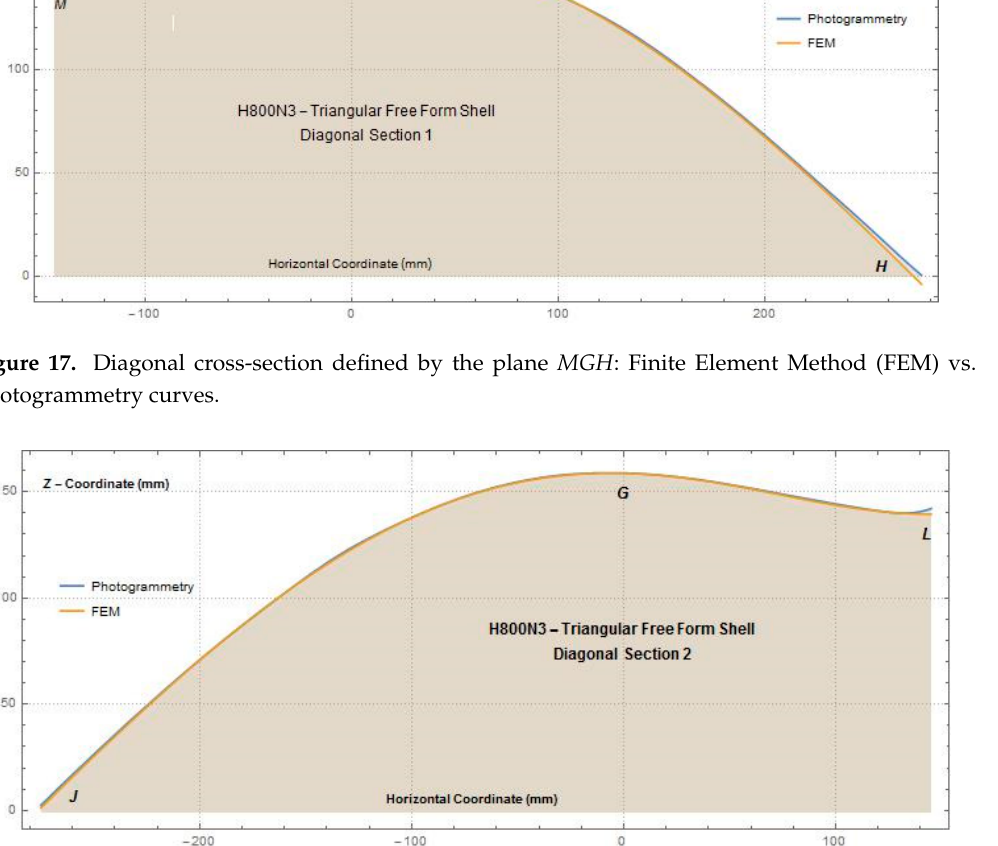
Figure 18. Diagonal cross-section defined by the plane JGL : Finite Element Method (FEM) vs. Photogrammetry curves. Infrastructures 2018 , 3 , x FOR PEER REVIEW